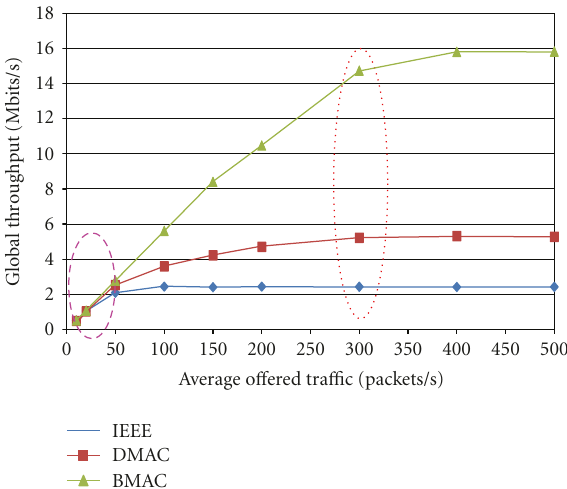
Table 1: Simulation setup.